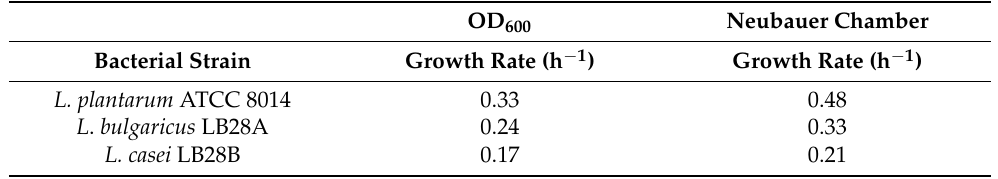
Table 1. Growth rates and doubling times of the three lactic acid bacteria tested. Data were obtained through OD 600 and cell counts with a Neubauer